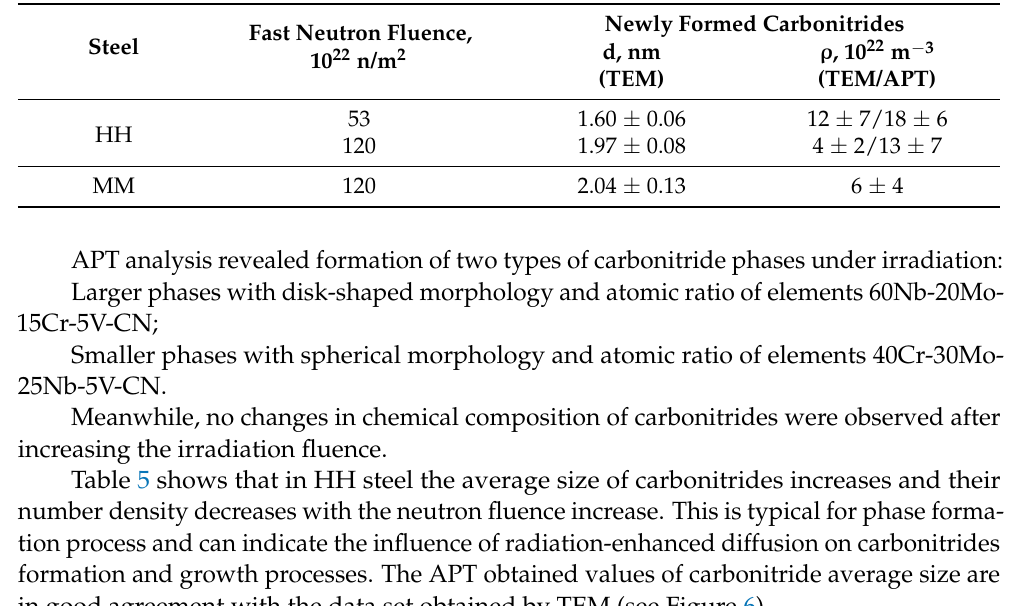
Figure 5. Typical dark-field TEM images of detected carbonitrides based on V, Mo and Nb after irradiation at 400 °C up to neutron fluences 53 × 10 22 n/m 2 ( b ) and 120 × 10 22 n/m 2 ( a , c ) in MM ( a ) and HH ( b , c ) steels, and typical APT maps of major carbide-forming elements distribution in HH steel ( d ) (arrows in TEM images indicate carbonitrides). Table 5. Parameters of newly formed nanoscale carbonitrides detected in MM and HH steels after irradiation at 400 °C to various neutron fluences .